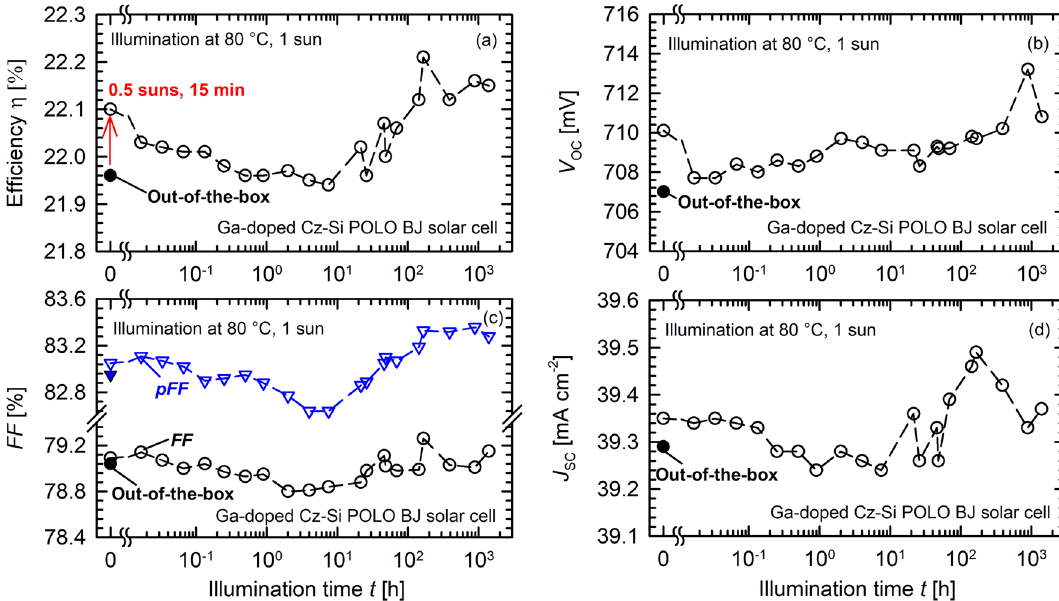
Figure 2. Long-term one-sun illumination of a POLO BJ solar cell on Ga-doped Cz-Si at 80 °C for 1400 h. Shown are the measured parameters ( a ) energy conversion efficiency η, ( b ) open-circuit voltage V OC , ( c ) fill factor FF together with the pseudo fill factor pFF , and ( d ) short-circuit current density J SC versus the illumination time t (open circles). In addition, the initial values measured directly after contact firing are shown (closed symbols). Before the experiment starts, the solar cell is illuminated at 0.5 suns for 15 min, increasing the efficiency from its initial value (slightly below 22%) to